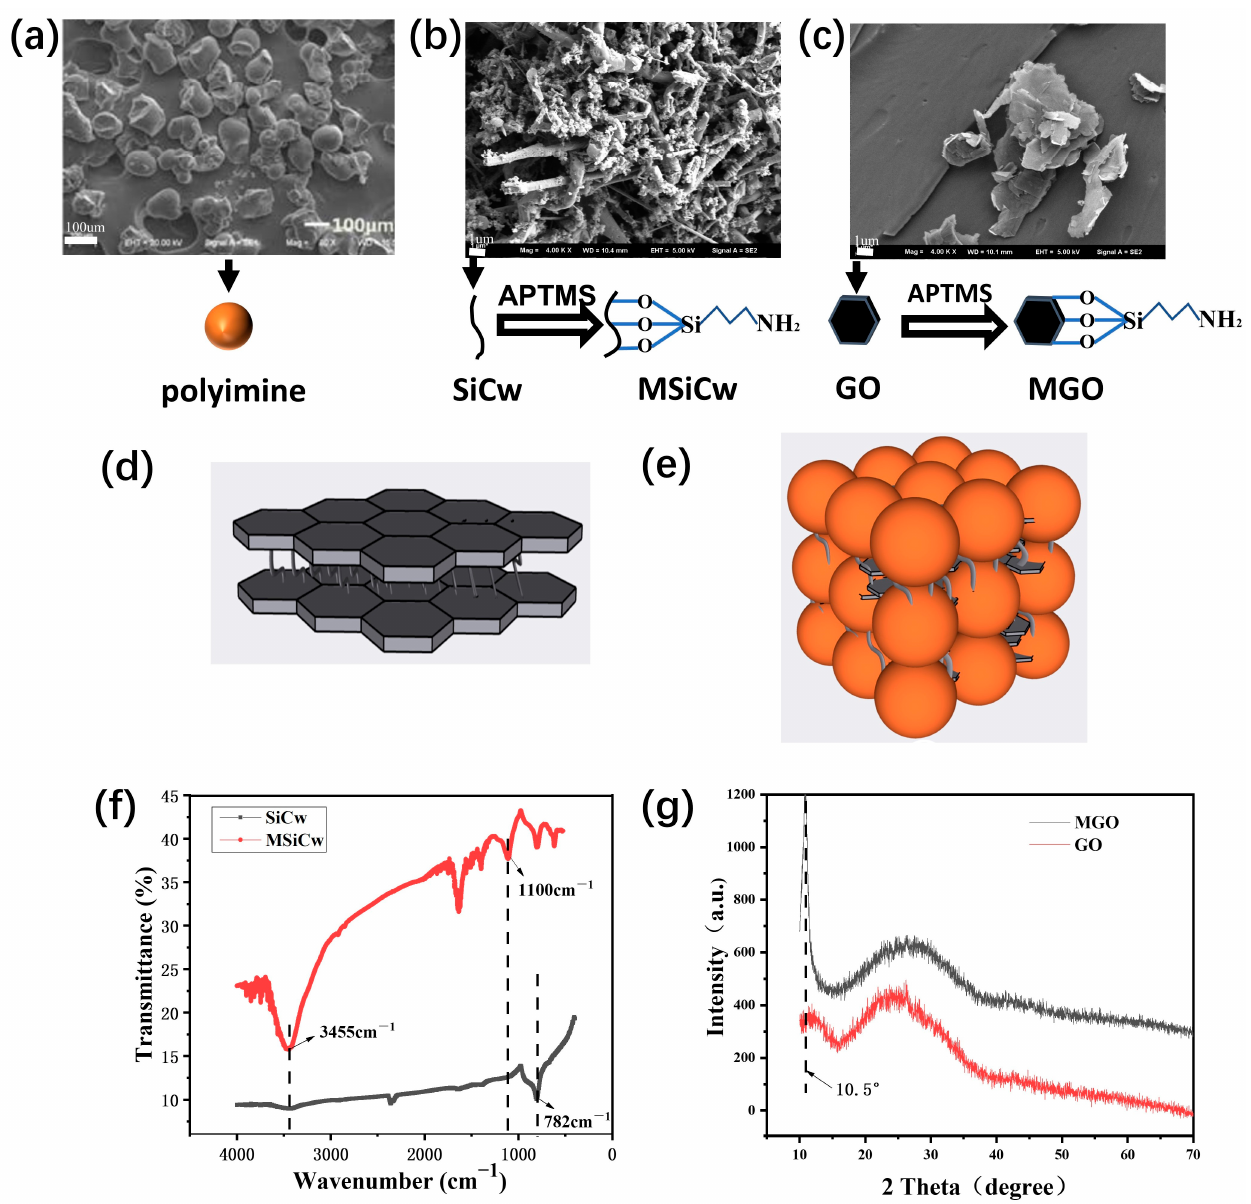
Figure 1. SEM images of polyimine ( a ), SiCw ( b ) and GO ( c ). Microscopic diagram of a natural nacre ( d ). Illustration of interface design of bioinspired layered ( e ). FTIR spectra: SiCw and MSiCw ( f ). XRD spectra: GO and MGO ( g ).